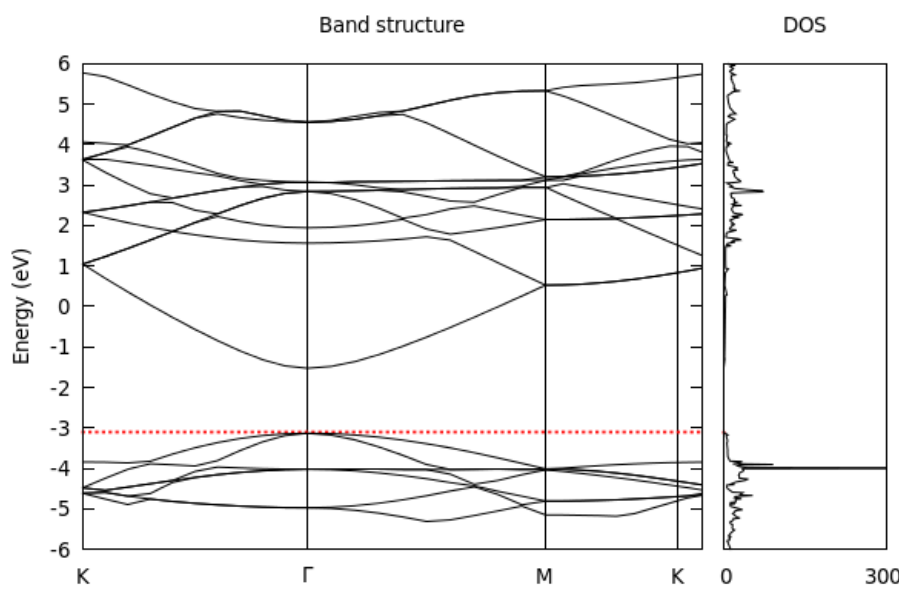
Figure 2: Band structure and DOS of ZnO in the monolayer graphene-like structure. The red dashed line is the Fermi level found for wurtzite.